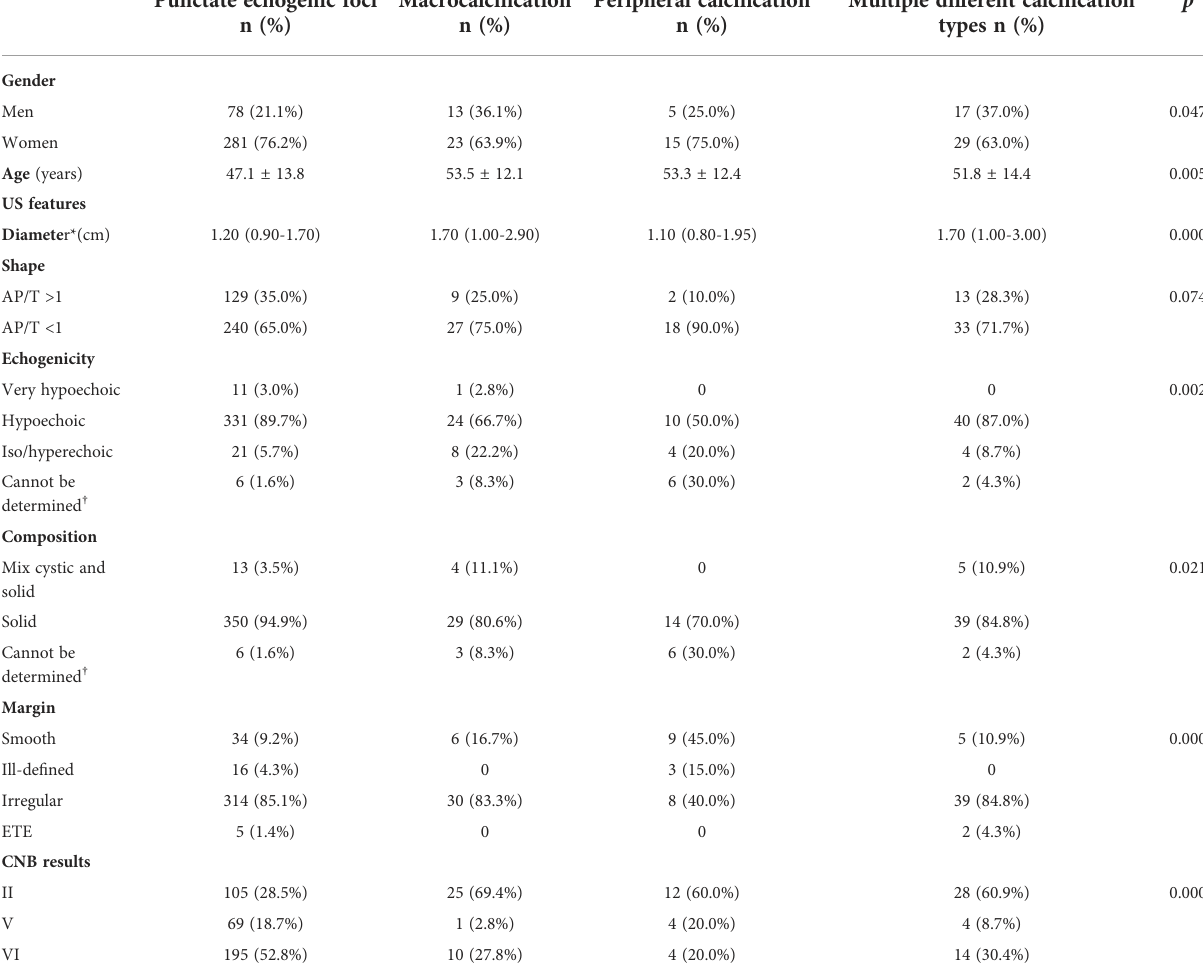
TABLE 1 US features and CNB results for thyroid nodules with different echogenic focus